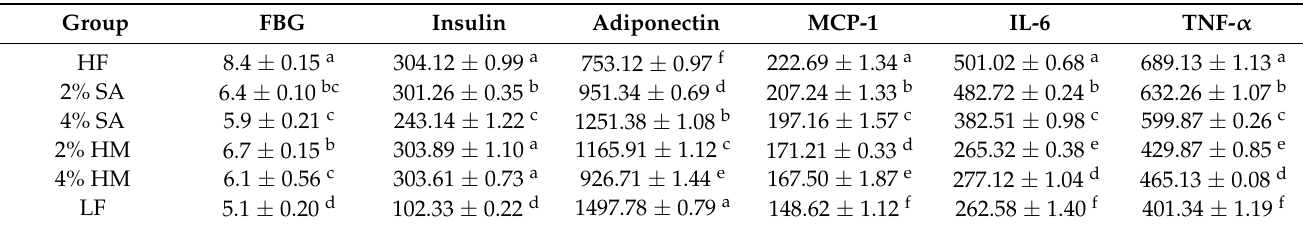
Table 3. The effects of the phospholipid on high fat diet